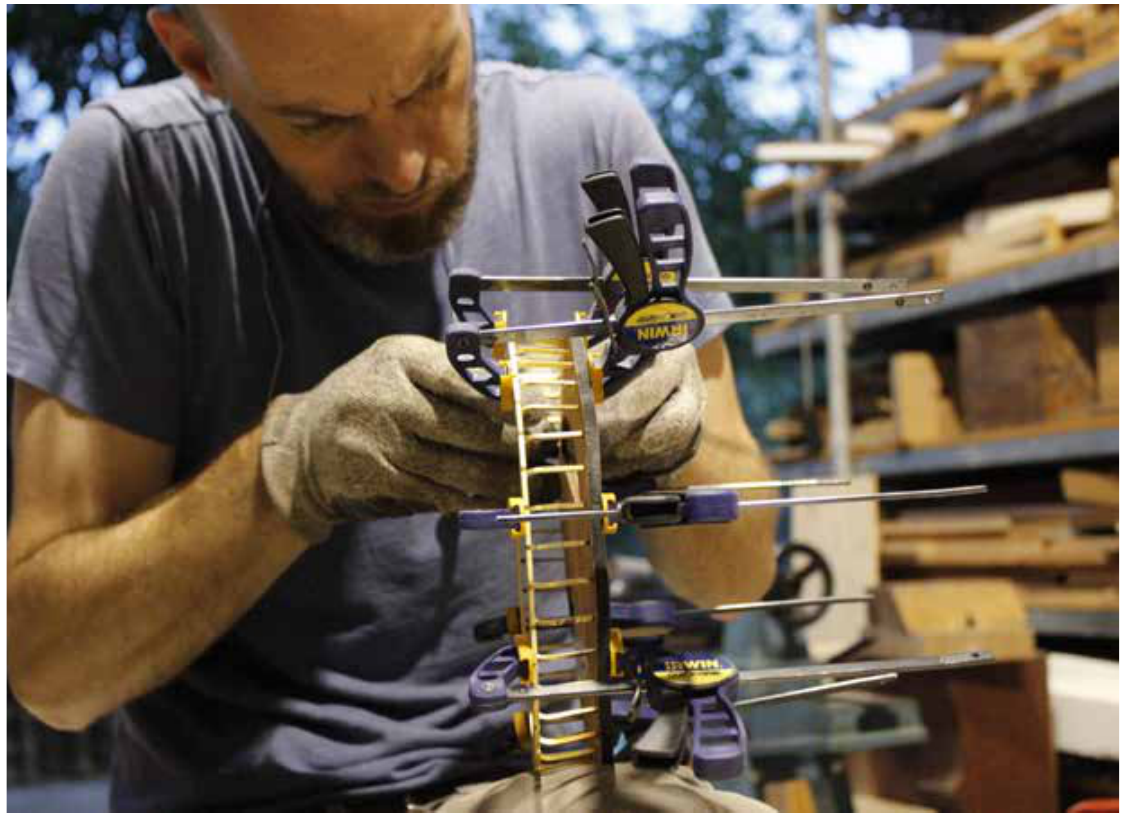
will slowly settle into a graceful form derived from repetitive use as the leather stretches against the brass. Both items can be seen in their assembled state in the upper right side of Figure 14. Source: